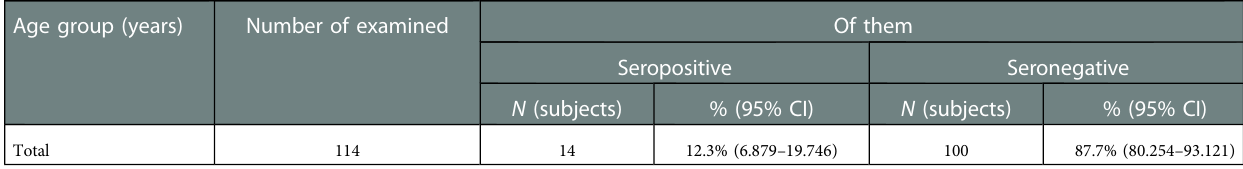
TABLE 3 IgG blood serum levels to diphtheria, tetanus, and pertussis in pregnant women at different stages of pregnancy. Antigen Trimester Total